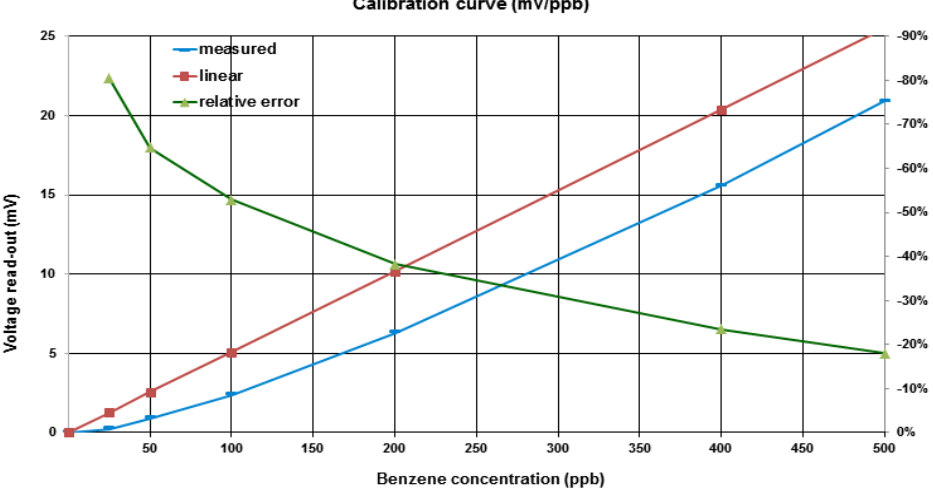
Figure 3. Measured vs. linear PID calibration curve and relative error.